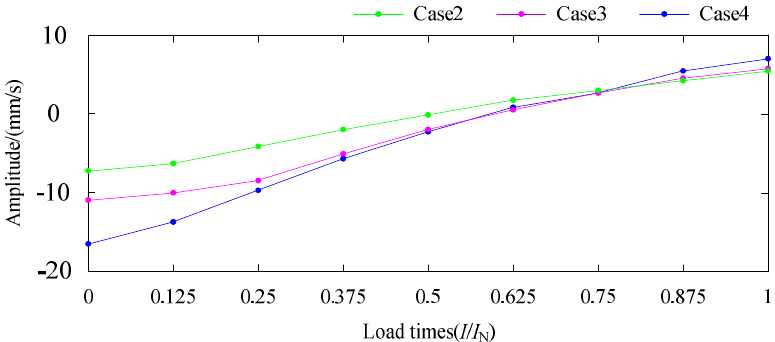
Figure 9. The velocity difference of stator vibration with load times.